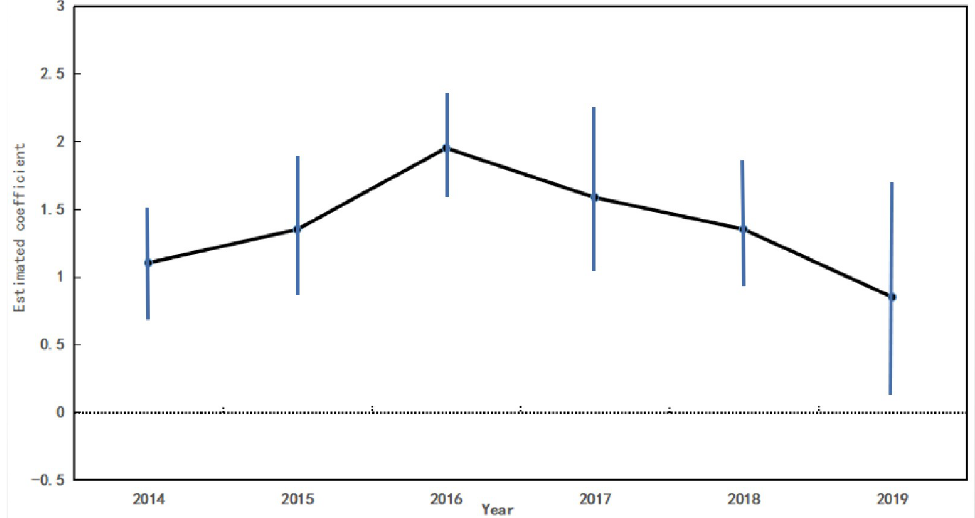
Fig 2. Year heterogeneity results of the effects of B&V on rural residents’